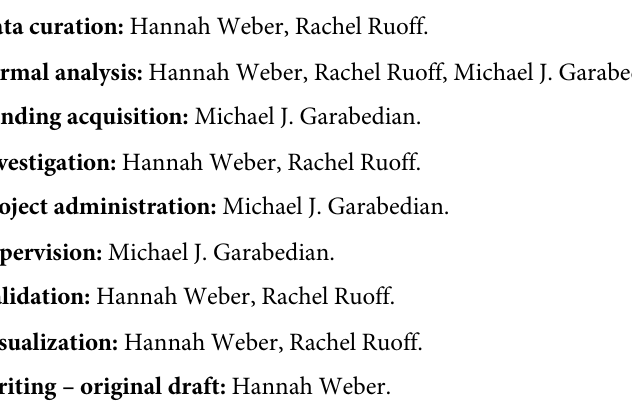
adjusted values, fold changes, and gene descriptions are shown for each gene. S5 Table. Response of MED19 LNCaP cells vs. control LNCaP cells to androgens. Top 100 androgen-induced (sheet 1) and androgen-repressed (sheet 2) genes for control LNCaP cells and MED19 LNCaP cells, with fold changes for each shown in comparison. Genes with 1.5-fold or more change in mRNA expression in response to androgen only in control LNCaP cells (sheet 3) or only in MED19 LNCaP cells (sheet 4). S6 Table. FLAG-MED19, AR, and H3K27ac occupancy in MED19 LNCaP cells at genes dif- ferentially expressed with MED19 overexpression in the absence and presence of andro- gens. Occupancy shown for androgen deprivation (sheet 1) and with R1881 treatment (sheet 2), with fold change in expression upon MED19 overexpression indicated. Androgen respon- siveness of each gene in control LNCaP cells and MED19 LNCaP cells is also indicated. AR occupancy scores for LRRTM3 (sheet 3), MAST4 (sheet 4), and MAOA (sheet 5). S7 Table. AR occupancy score QC and background peaks. AR occupancy scores for PSA and FKBP5 (sheet 1); and list of background peaks for IgG (sheet 2) and FLAG in control LNCaP cells (sheet 3) for